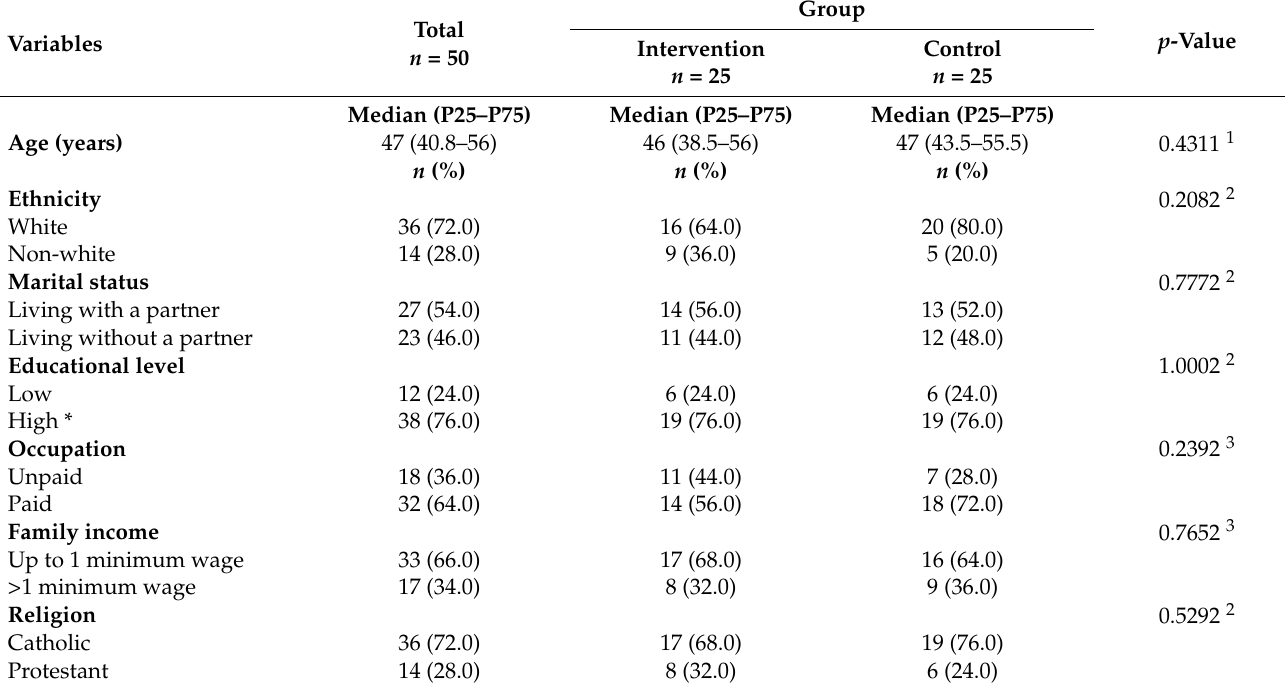
Table 1. Characterization and homogeneity of the participants in the intervention and control